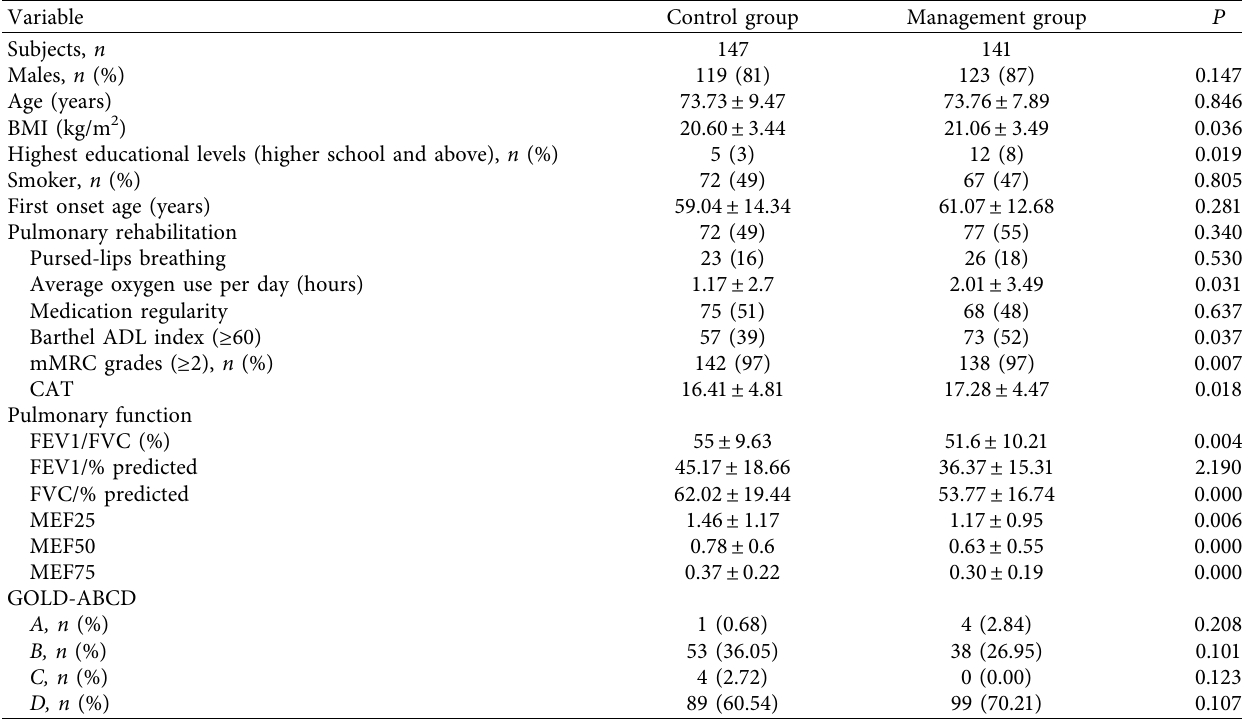
Table 1: Baseline characteristics of